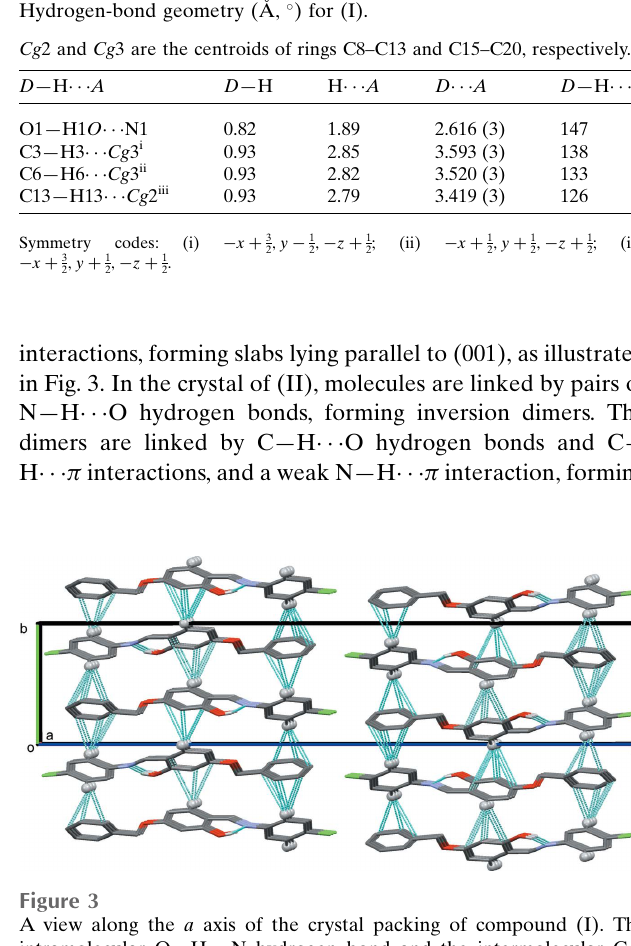
Table 2 Hydrogen-bond geometry (A˚ , (cid:3) ) for (II).